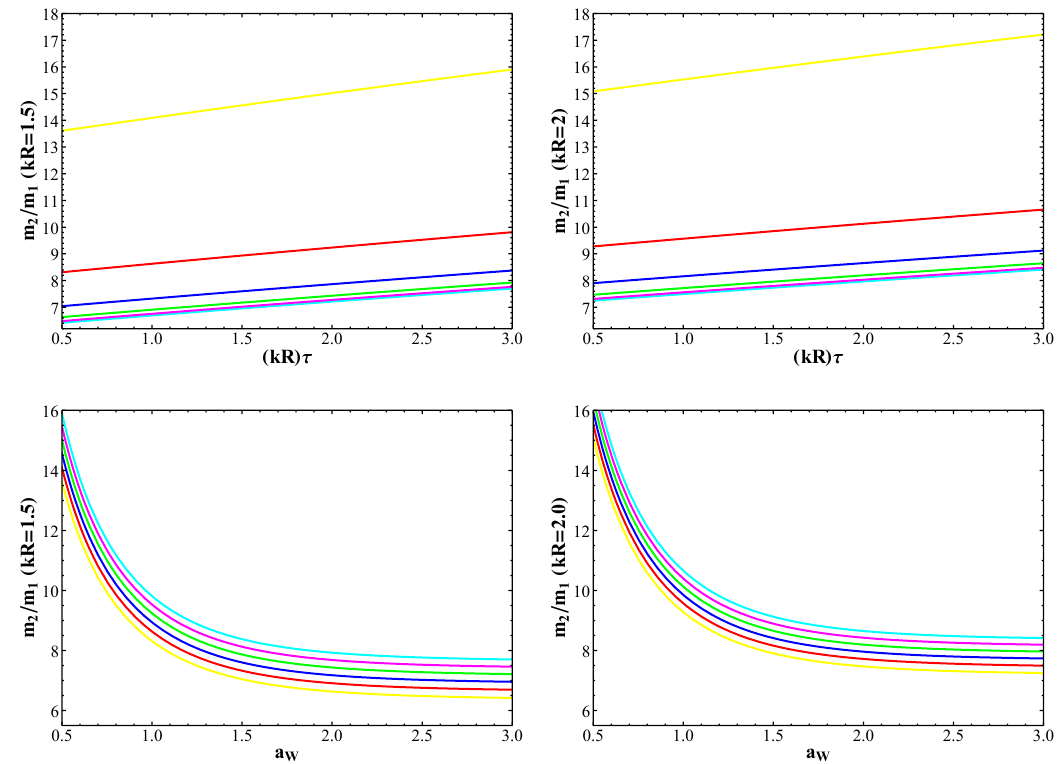
Figure 12 . (Top left) The mass ratio of the lowest two dark photon KK states, m 2 /m 1 = x W assuming kR = 1 . 5 , as a function of ( kR ) τ for a W = 3 (cyan), 5/2 (magenta), 2 (green), 3/2 (blue), 1 (red), and 1/2 (yellow), respectively. (Top right) As in the top left, but now assuming kR = 2 . 0 . (Bottom left) As in the top left, but now as a function of a W assuming ( kR ) τ = 3 (cyan), 5/2 (magenta), 2 (green), 3/2 (blue), 1 (red), and 1/2 (yellow), respectively. (Bottom right) As in the bottom left, but assuming kR = 2 . 0